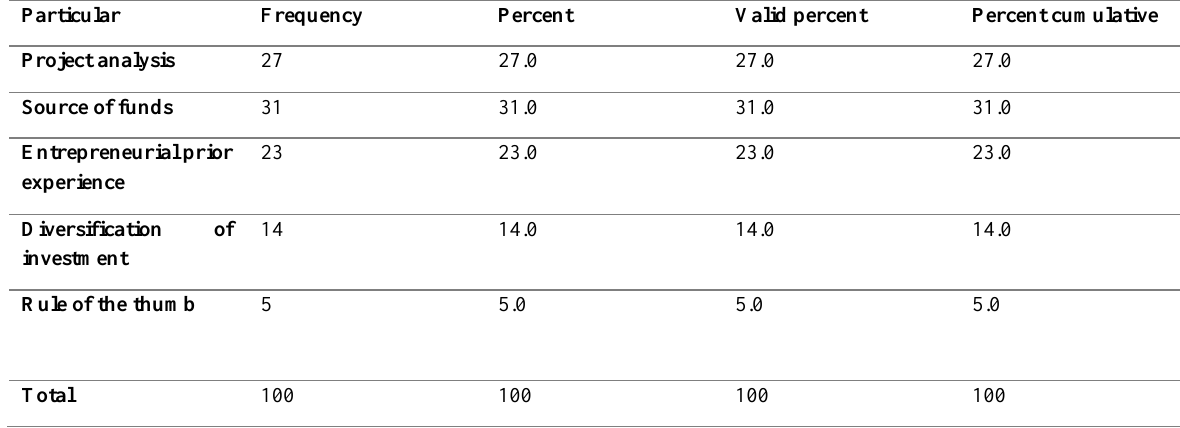
Table 8: Investment